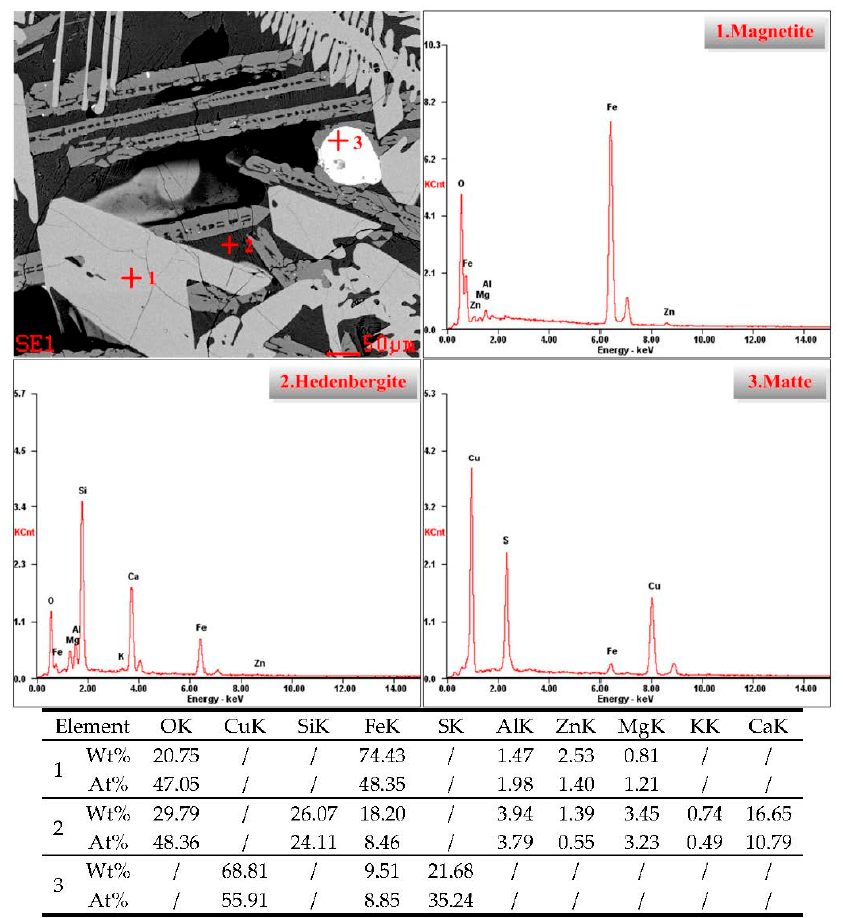
Figure 13. Scanning electron microscope and energy dispersive spectrometer (SEM-EDS) analyses of the modified slag (0.45 of binary basicity, blending with 12% of compound additive, modifying at 1350 °C for 120 min and cooling at 1.5 °C/min down to 900 °C).